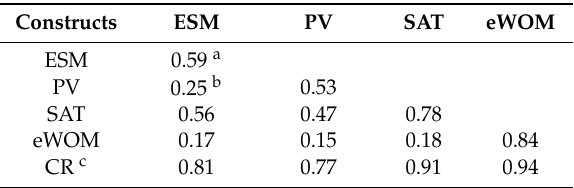
Table 2. Convergent and discriminant